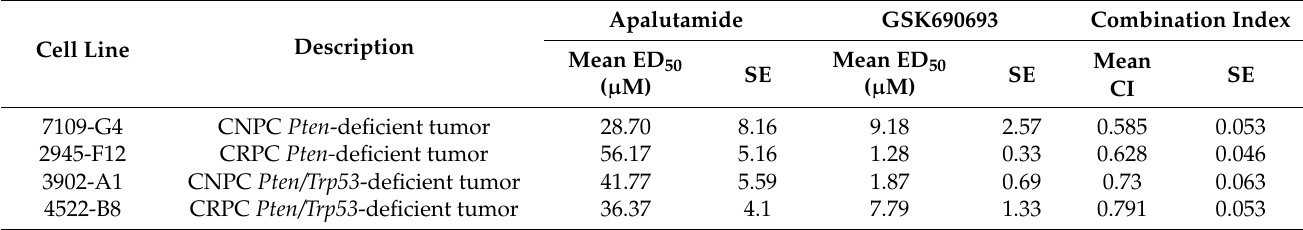
Table 1. Summary of the mean effective dose for 50% growth inhibition (ED 50 ) of apalutamide and GSK-690693 and the combination index (CI) at ED 50 for mouse prostate cancer cell